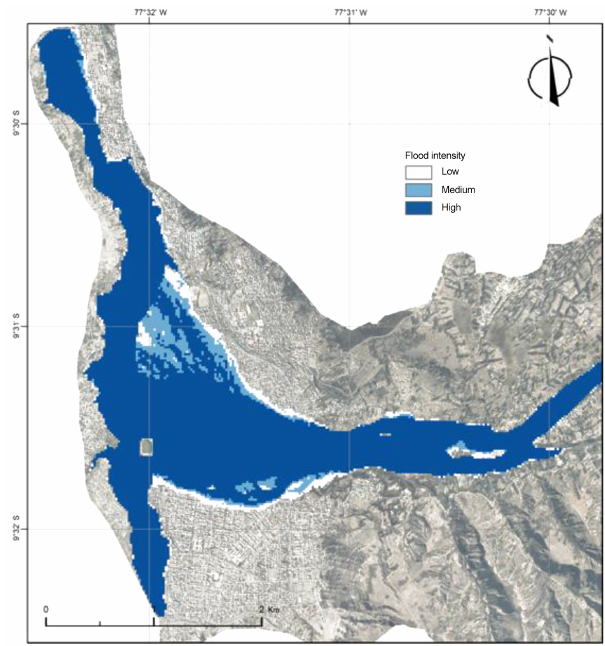
Figure 10. Flood intensity in Huaraz associated with a probable maximum inundation GLOF from Lake Palcacocha for the scenario of a 0m lake-lowering condition and a large